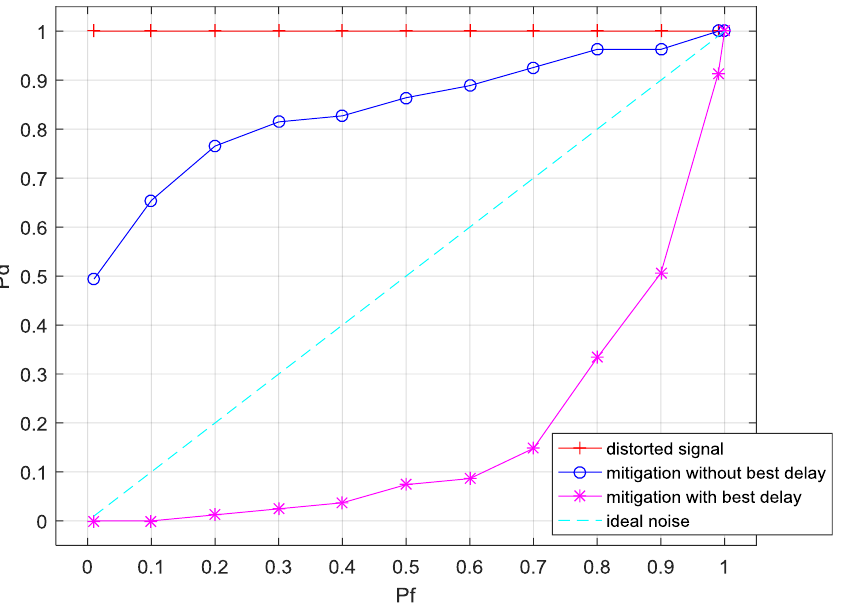
Figure 10. The receiver operating characteristics (ROC) before and after nonlinearity mitigation. Finally, constellations of the distorted weak 16QAM by the intermodulation components are calculated in Figure 11. Randomly-distributed constellation points become regular after the nonlinearities are eliminated. This result is also the same as that obtained in the simulation signal.